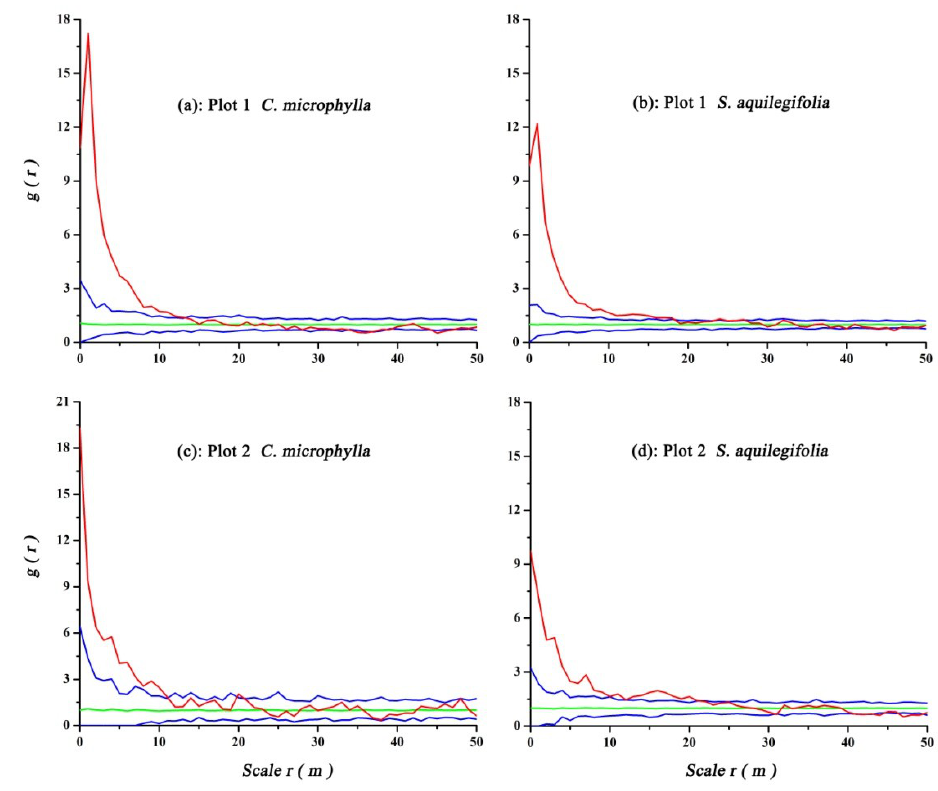
Figure 6. Spatial pattern of different shrubs with the CSR null model. Graph colors are defined in Figure 4.